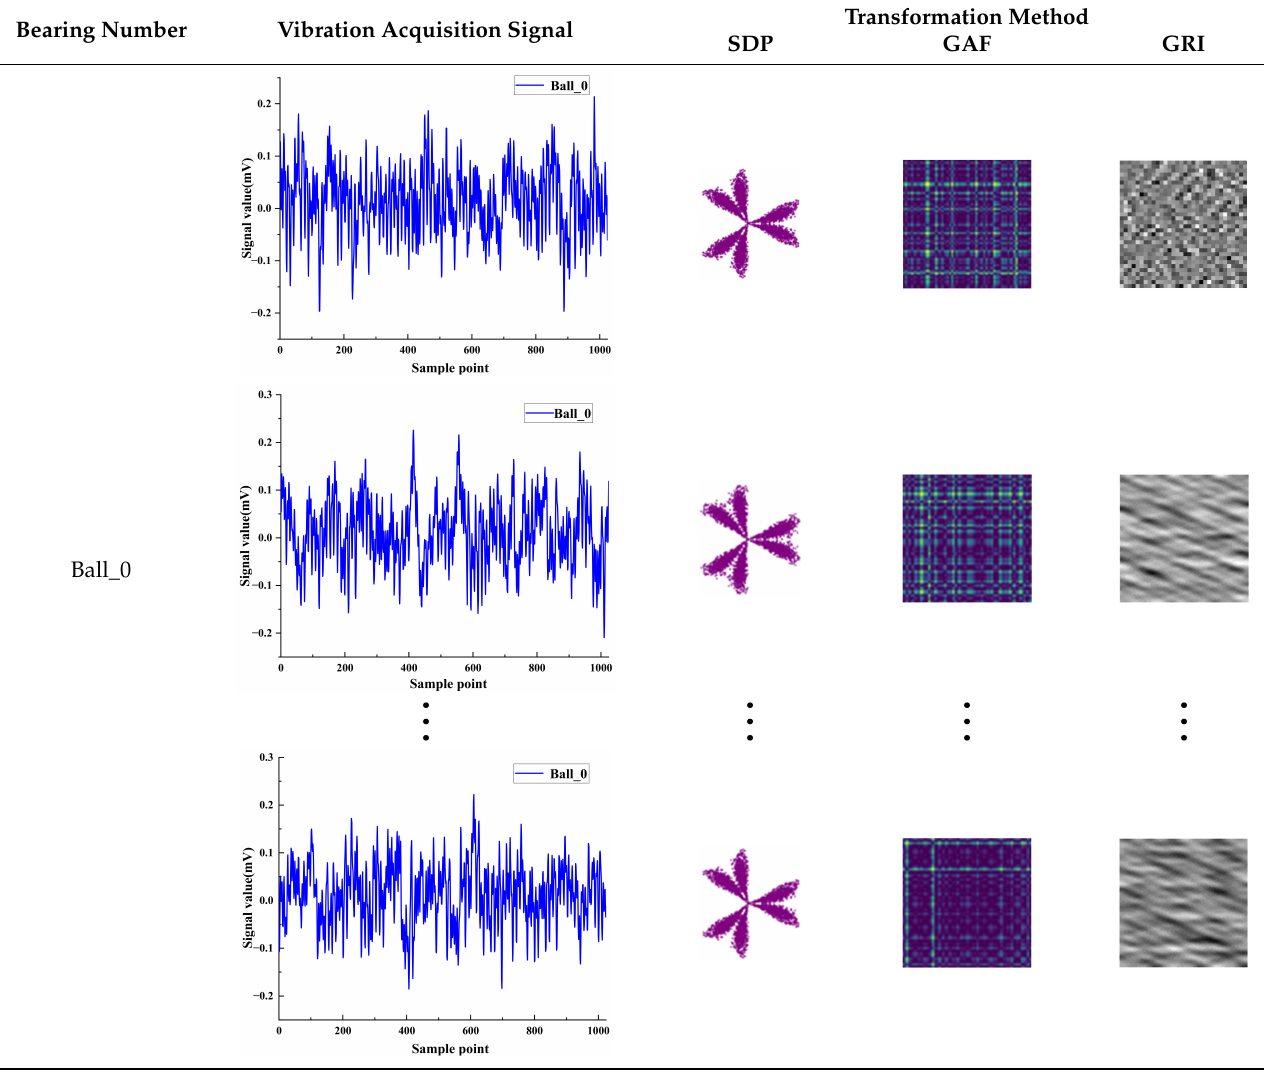
Table 2. Transformation images of bearing vibration signals by SDP, GAF and GRI method. Bearing